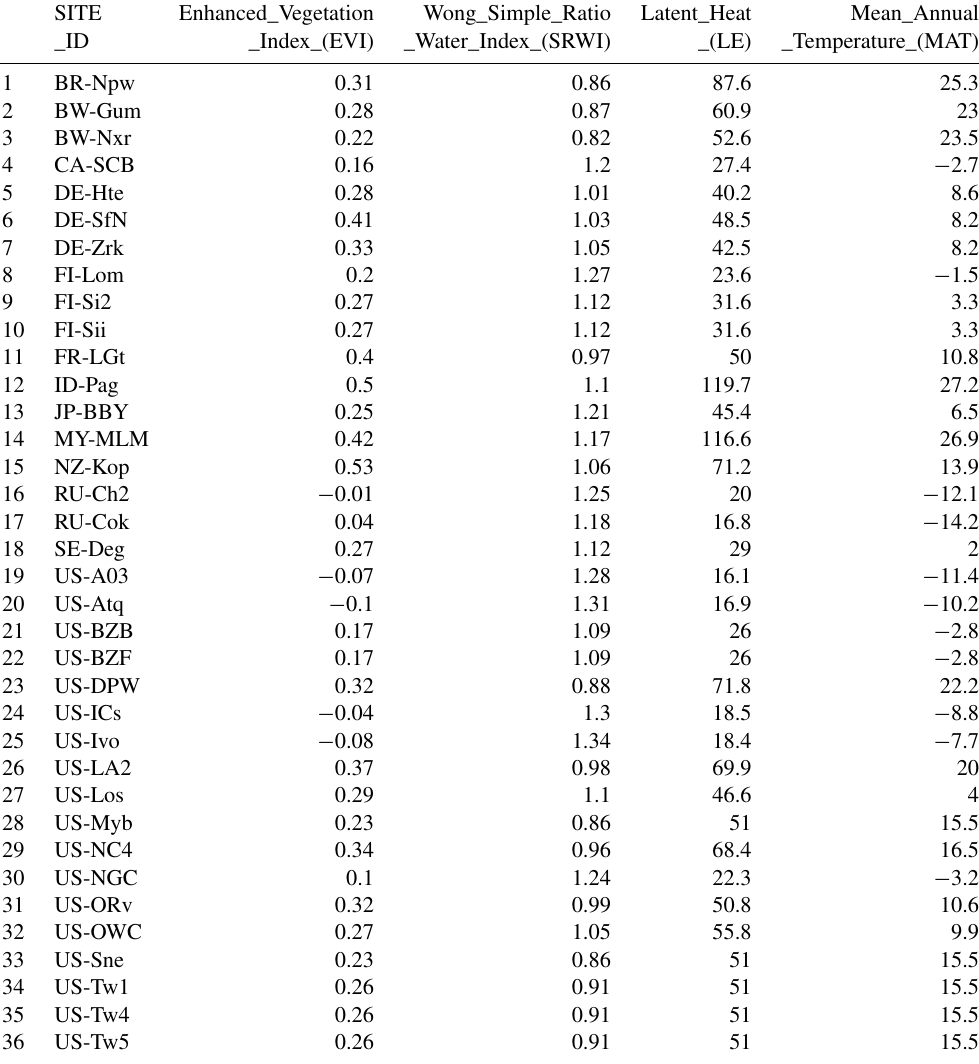
Table B4. Table of bioclimatic predictor data used in the principal component analysis (PCA) of Fig.